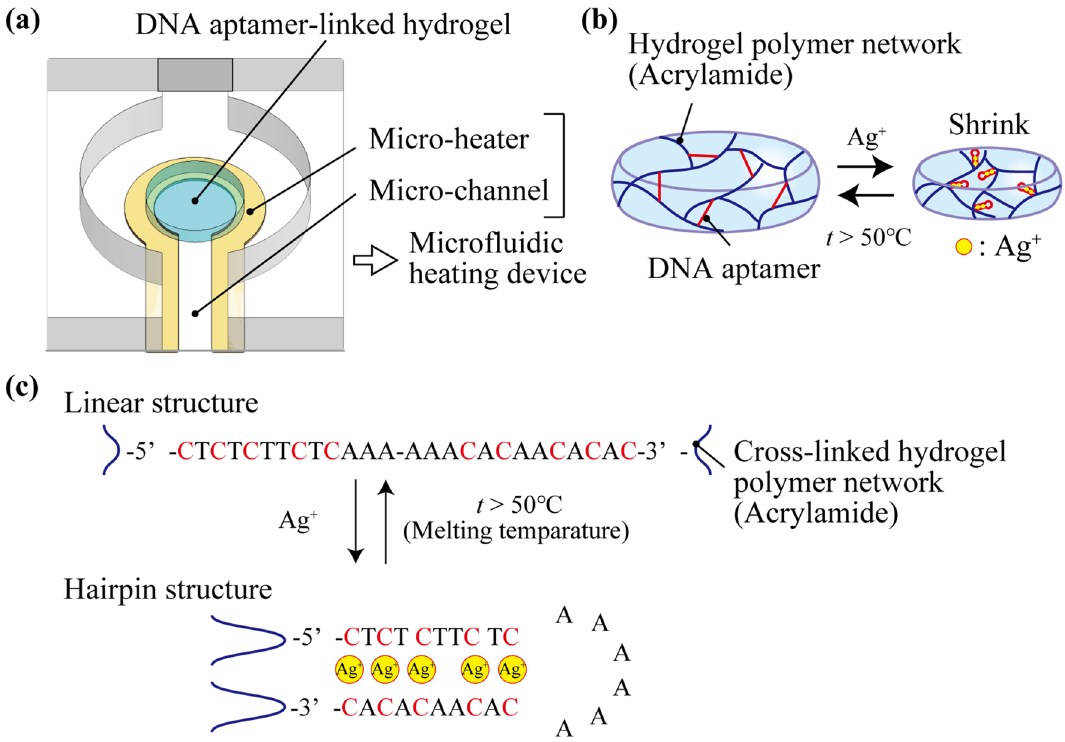
Figure 1. ( a ) Schematic illustration of the DNA aptamer-linked hydrogel biochemical sensor integrated with the microfluidic heating device for repeatable detection of chemical substances. ( b ) The DNA aptamer-linked hydrogel changes its volume caused by forming the hairpin structure of the DNA aptamer capturing Ag + ions. ( c ) The structure of Ag-DNA aptamer reversibly changes through binding and dissociating the Ag +